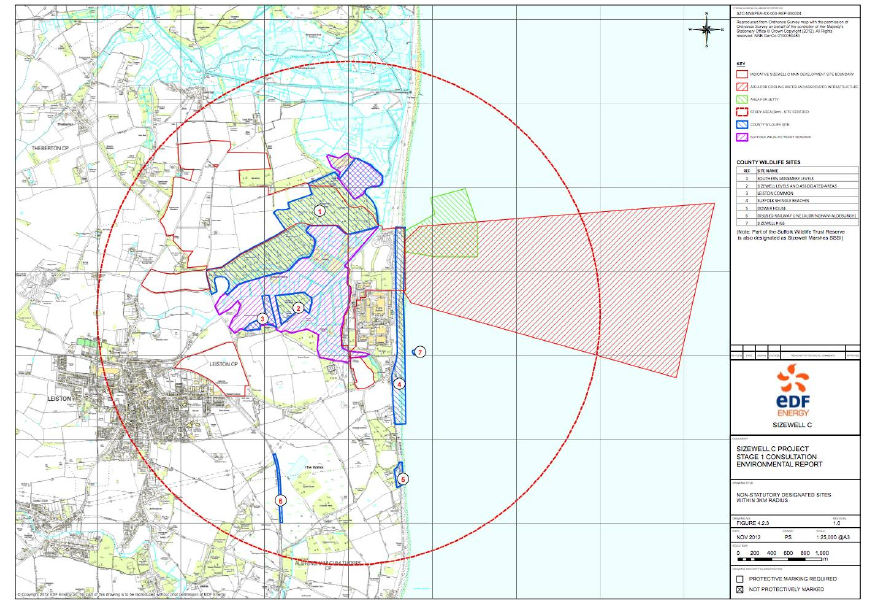
Figure 2. Suffolk coastline featuring nuclear Sizewell nuclear power stations and Minsmere RSPB reserve. Nuclear neighbourhood repre- sented by EDF 20km environmental impacts buffer. Source: EDF Energy (2012), Stage 1 Consultation